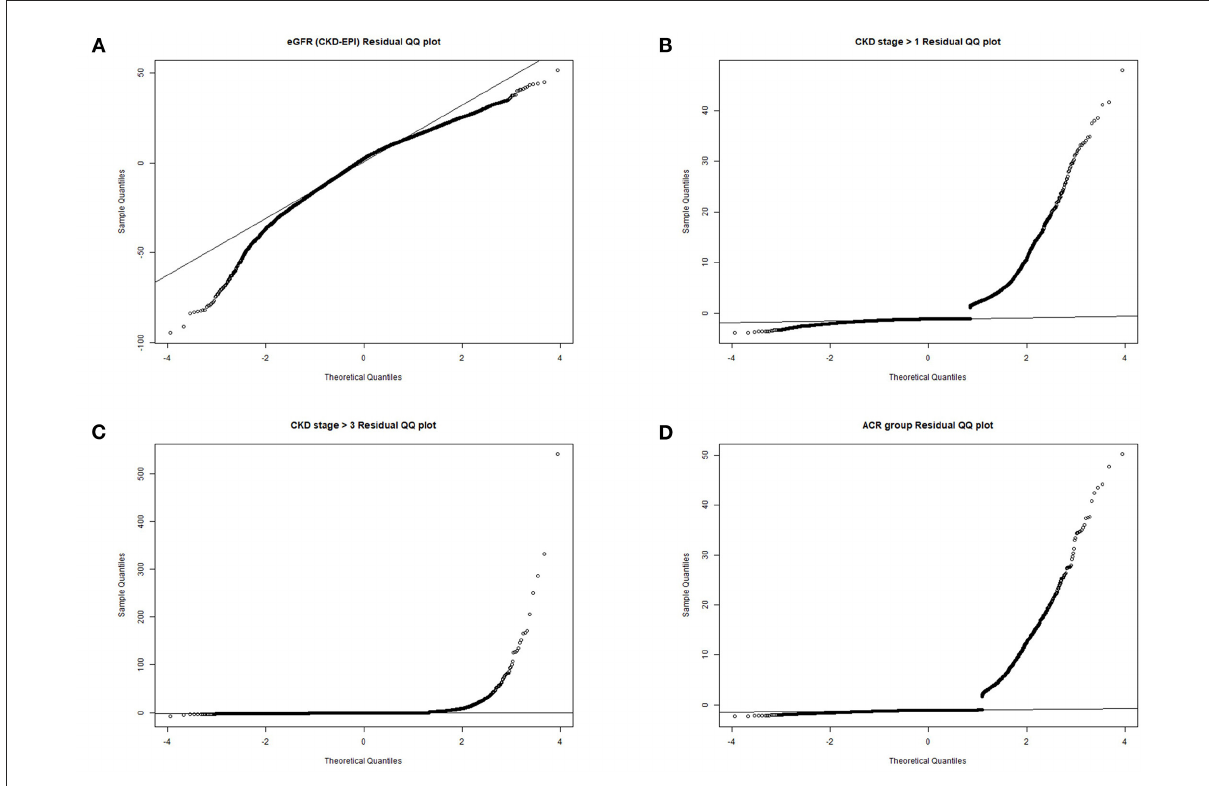
FIGURE2 QQ plots of residues. (A) eGFR residual QQ plot; (B) CKD stage > 1 residual QQ plot; (C) CKD stage > 3 residual QQ plot; (D) albuminuria residual QQ